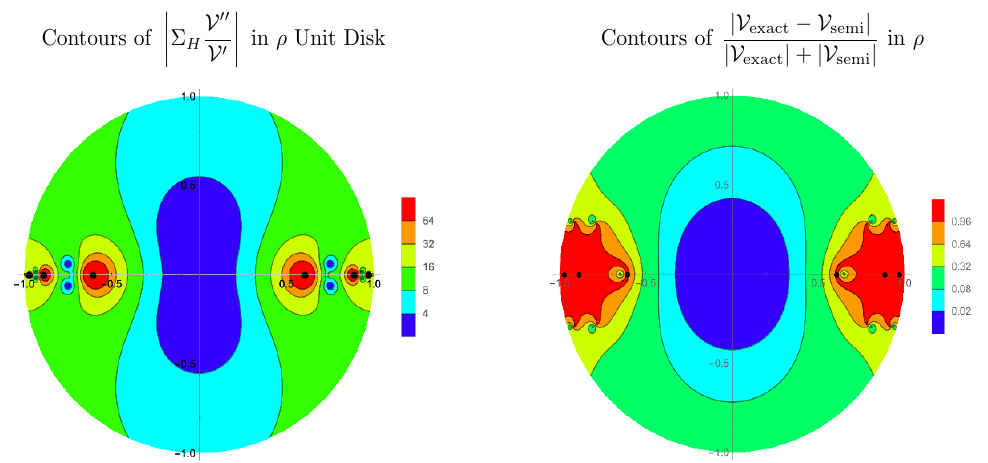
Figure 17 . The (cid:12)gure on the left shows a contour plot of the function in the (cid:26) unit disk with h L = 1 and h H = c and semiclassical Virasoro vacuum blocks with the same parameters and c = 60. The positions of the forbidden singularities are indicated with black dots. The plot on the left can be viewed as a kind of analytic prediction for the deviation plotted on the